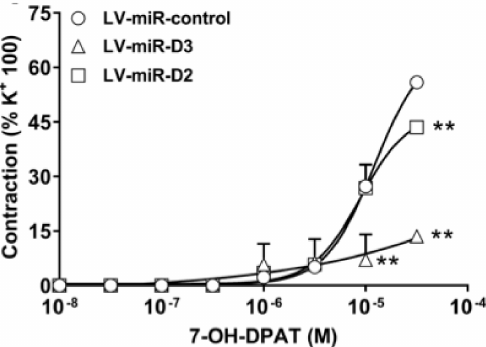
Figure 5. Vasoconstriction induced by 7-hydroxy-2-dipropylaminotetralin (7-OH-DPAT), in aortic segments from wild-type treated with lentiviral vectors delivering synthetic miRNA (LV-miR-control, scrambled sequence; LV-miR-D3, targeting D3R; LV-miR-D2, targeting D2R). Each curve (with vertical bars representing standard errors) represents the average from 6 preparations. Two-way ANOVA, (LV-miR: F (2,56) = 12.91 p < 0.0001; agonist conc.: F (7,56) = 75.17, p < 0.0001; LV-miR × agonist conc. F (14,56) = 7.90, p < 0.0001) and Bonferroni’s test (** p < 0.01 vs.